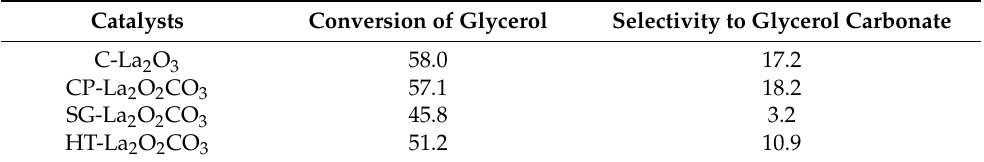
Table 3. Reaction of glycerol and CO 2 over lanthanum-based catalysts. Reaction condition: P = 45